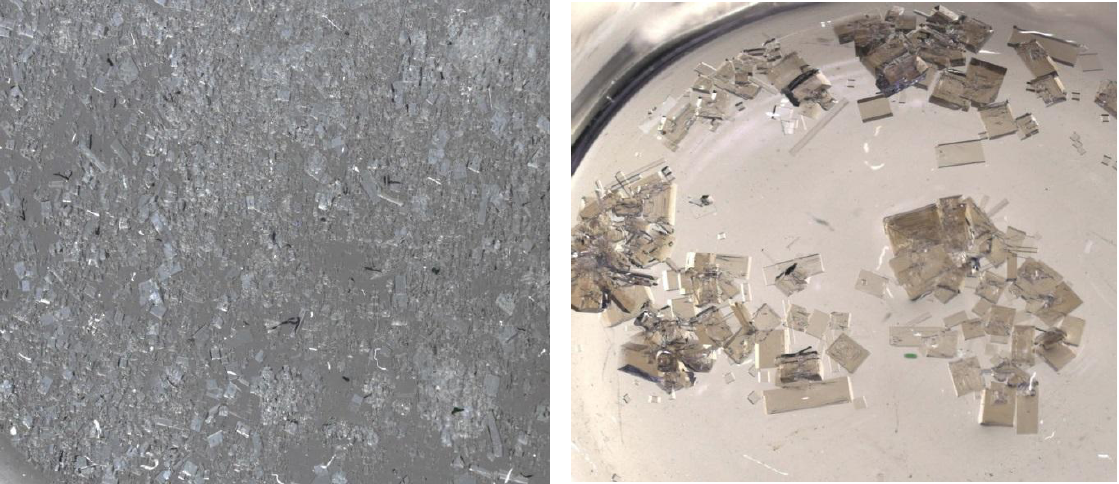
Figure 2. Examples of NaClO homochiral distributions of crystals obtained from 3 an aerosol crystallization experiment ( Left ) and a steady crystallization experiments ( Right ). The biggest crystals are a few mm size. (Left) Dextro homochiral NaClO crystals 3 (here seen as light crystals) obtained from the co-crystallization with 4 ppm of DL -Phe and an external upwards pointing magnetic field (B ). (Right) Levo (here seen as dark crystals) ↑ homochiral crystals obtained from the co-crystallization with 20 ppm of DL -Phe and an external downwards pointing magnetic field (B ↓